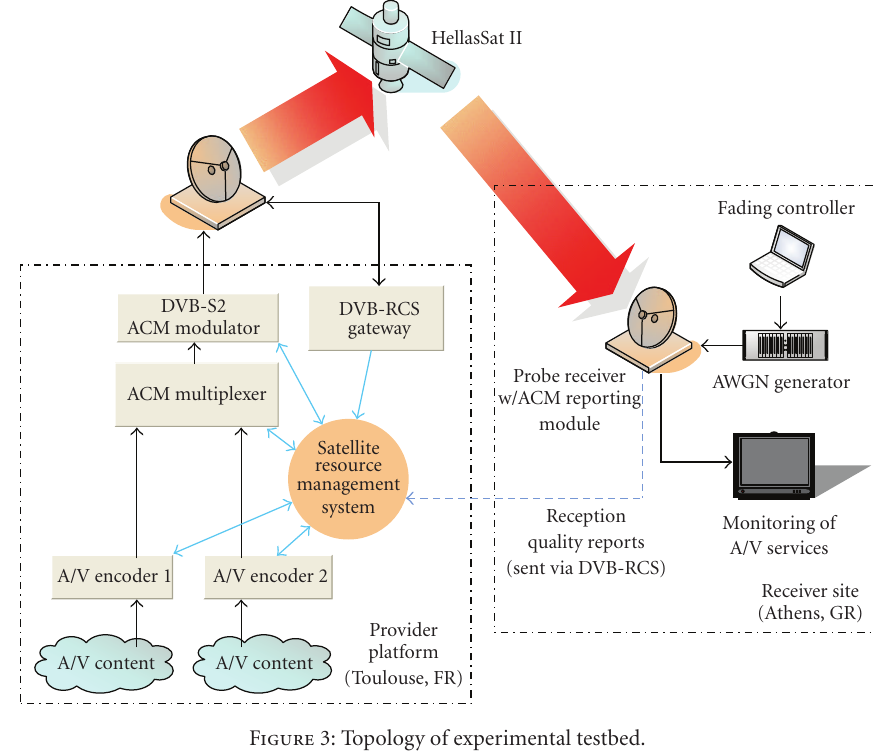
Figure 3: Topology of experimental testbed.